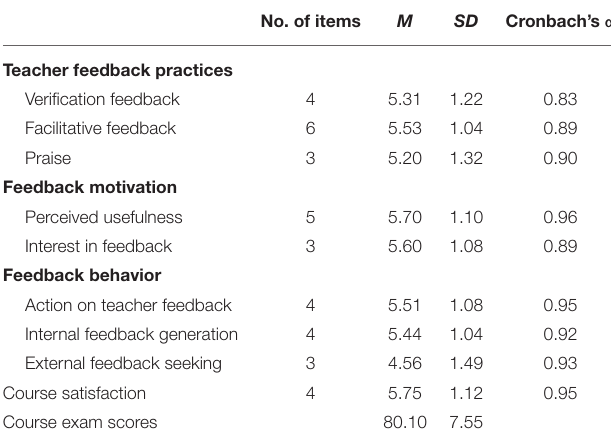
TABLE 2 | Descriptive statistics and reliabilities ( n =